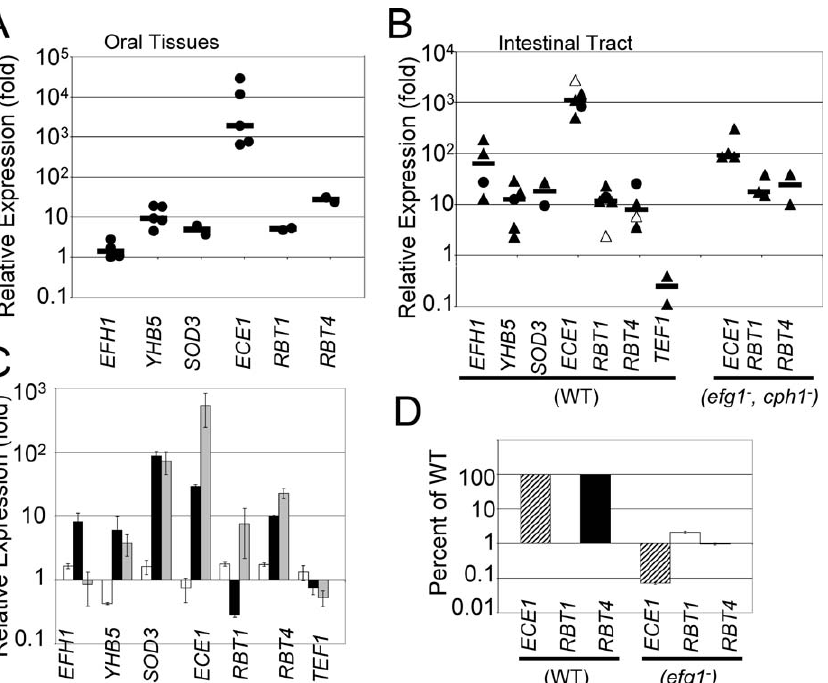
Figure 1. Expression of C. albicans Genes Expression of genes of interest in cDNA preparations was determined by qRT-PCR as described in Materials and Methods. Results were normalized using actin expression and are expressed relative to a reference sample of laboratory-grown log phase cells. (A) Gene expression in C. albicans cells recovered from the oral cavities or esophagi of IGB piglets. Closed circles, WT C. albicans cells (SC5314) recovered from the tongue, roof of the mouth, or esophagus; bars, geometric means. (B) Gene expression in C. albicans cells recovered from the intestinal tract. Closed circles, WT C. albicans cells (SC5314) recovered from the large intestine of an IGB piglet; closed triangles, WT (SC5314 or DAY185), or mutant ( efg1 cph1 double null) C. albicans cells recovered from the cecum of Swiss Webster mice; open triangles, WT C. albicans (SC5314) recovered from the ileum of Swiss Webster mice; bars, geometric means. (C) Gene expression during laboratory growth. White bars, log phase C. albicans grown in rich medium at 37 8 C; black bars, post-exponential phase C. albicans grown in rich medium at 37 8 C; grey bars, hyphal C. albicans grown in RPMI-serum at 37 8 C; error bars, standard deviation. (D) Comparison of gene expression in WT C. albicans (DAY185) and in an efg1 deletion mutant grown in RPMI-serum at 37 8 C. Cross-hatched bars, relative ECE1 expression; white bars, relative RBT1 expression; black bars, relative RBT4 expression; error bars, standard deviation. doi:10.1371/journal.ppat.0030184.g001 Figure 1. In C. albicans cells recovered from oral infection, five of the genes were highly expressed relative to their expression